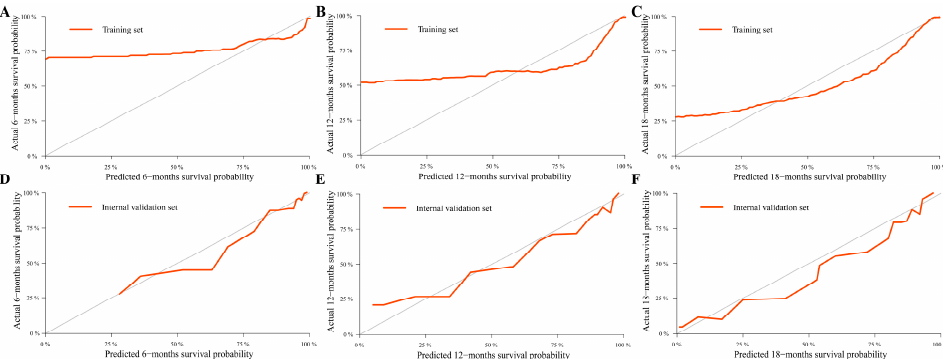
Figure 4. Calibration plots for predicting overall survival (OS). Calibration curves for predicting 6-, 12-, and 18-month OS in the training set ( A – C ) and internal validation set ( D – F ). The black line represents the comparison between the observed survival probability, and the prediction probability the gray line represents the ideal prediction.